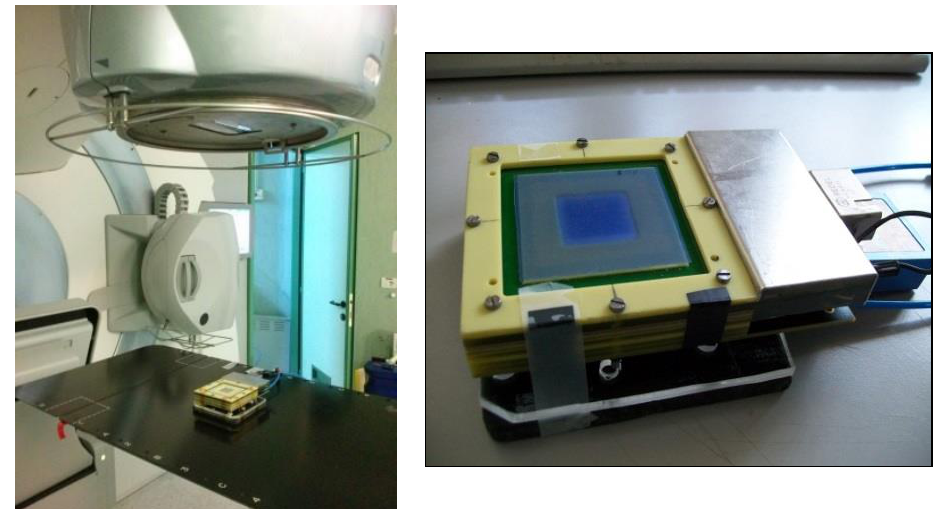
Figure 6. The GEMPix placed in position for irradiation with the Elekta Synergy Linac at the Tor Vergata Radiotherapy Centre ( left ) and the EBT gafchromic film placed on the detector window after irradiation ( right ) [21].